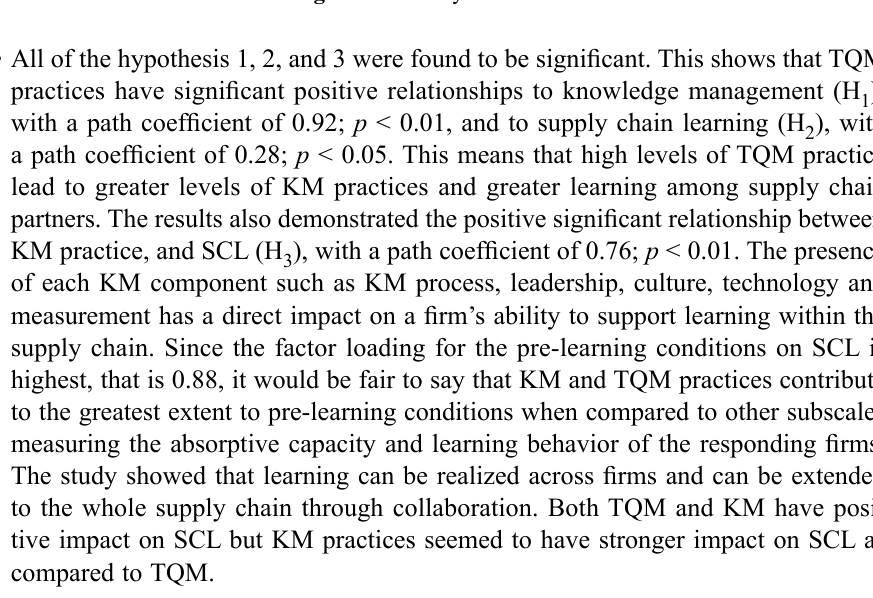
Fig. 2. Path analysis